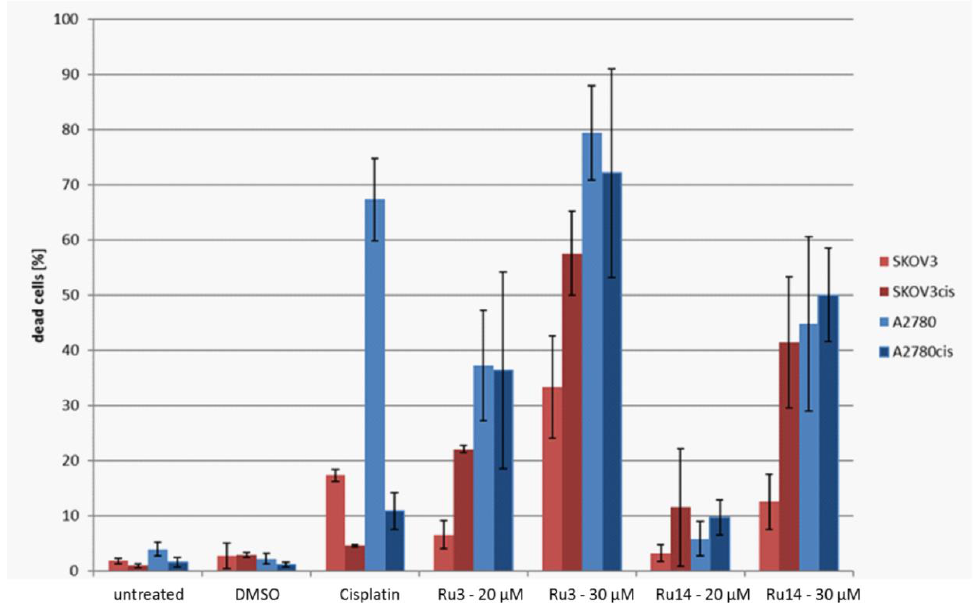
Figure 7. Cell death rates induced by 15 µ M Cisplatin or 20 µ M and 30 µ M Ru3/Ru14 in A2780 and SKOV3 cells. Untreated or DMSO treated cells served as controls. Cells were incubated for 48 h. The number of dead cells was measured via PI staining.